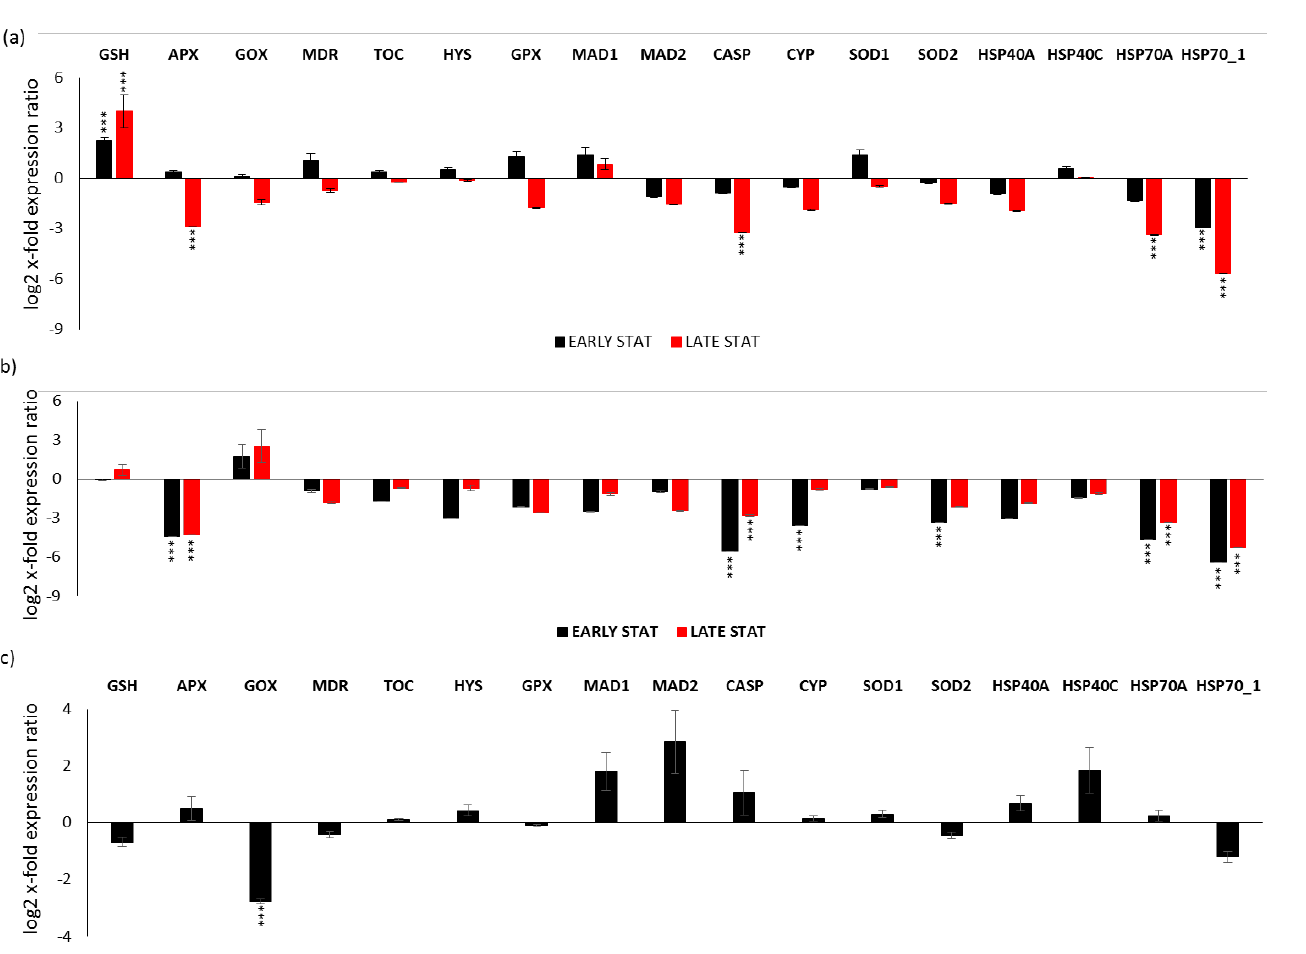
Figure 4. Expression levels of selected stress responsive genes in P. tricornutum cells in: ( a ) Replete condition early stationery and late stationery compared to the control condition (Replete; x-axis) exponential phase; ( b ) LOW SI condition early stationery and late stationery compared to the LOW SI condition exponential phase; ( c ) LOW N early stationery phase compared to LOW N exponential phase. Data are represented as log2 x-fold expression ratio ± SD (n = 4; ** p < 0.01 and *** p < 0.001, Student’s t -test). Abbreviations stands for glutathione synthase (GSH), ascorbate peroxidase (APX), glycolate oxidase (GOX), multidrug resistance protein (MDR), tocopherol cyclase (TOC), hystone deacetylase (HYS), glutathione peroxidase (GPX), mitotic spindle assembly checkpoint proteins (MAD1 and MAD2), metacaspase (CASP), cytochrome P450 (CYP450), superoxide dismutase 1 and 2 (SOD1 and SOD2, respectively) and heat shock proteins 40A, 40C, 70.1, and 70A (HSP40A, HSP40C, HSP70_1, HSP70A). 3. Discussion Microalgae are continuously exposed to various stressors in the natural environ- ment, including both biotic and abiotic stressors. Upon exposure, cells react in order to cope with the stressor and survive, such as by activating antioxidant and xenobi- otic-degrading enzymes, defense systems, and remodeling cellular metabolism [51,52]. In addition, in certain stressful conditions, it has been shown that microalgae may activate enzymatic pathways responsible of the synthesis of secondary metabolites with potential bioactivities for human health. This is the case of polyunsaturated aldehydes, shown to have anticancer properties [53], which are produced by the diatom Skeletonema marinoi at the end of the stationery phase (depending on nutrient stress exposure) [44]. However, this is not a rule. In fact, it was shown that the production of bioactive compounds is different depending on the species, clones, growth phases, and exposure to biotic and abiotic interferences [46,54,55], including predator exposure [26]. This phenomenon is